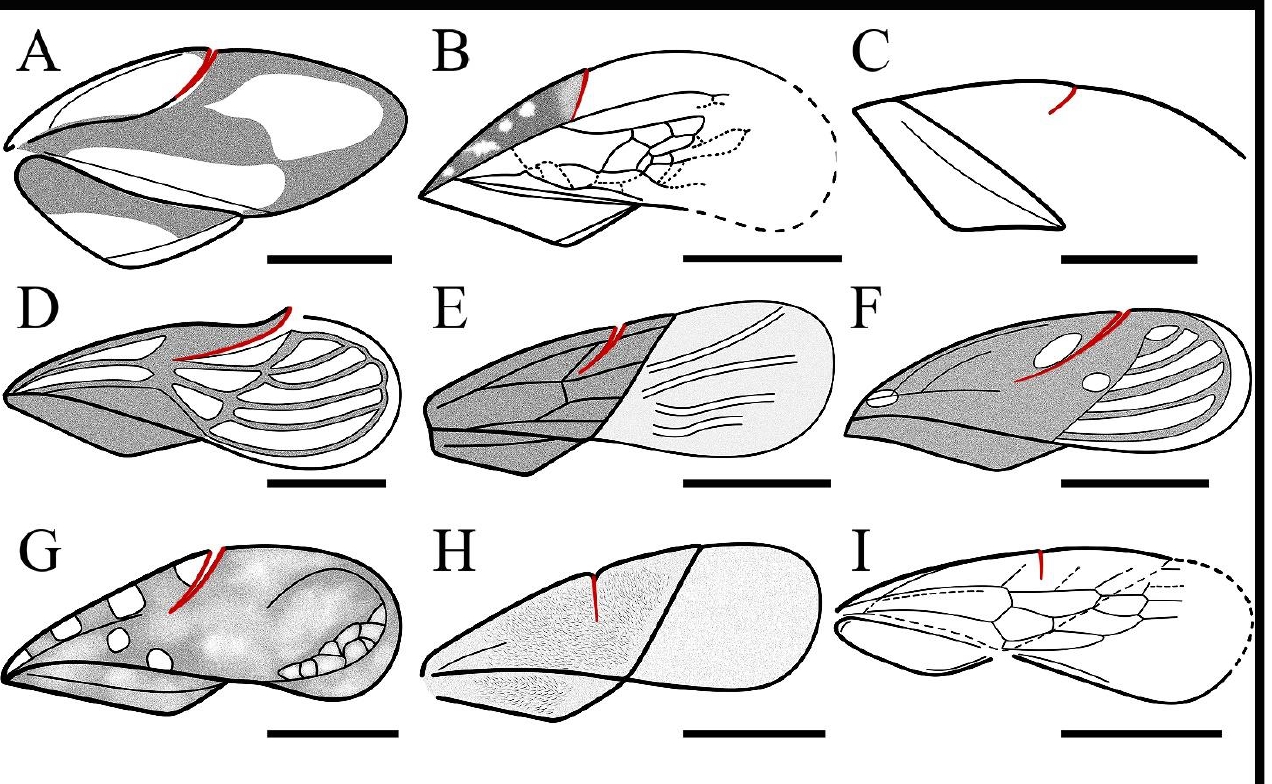
Figure 5. Redrawn from the forewings of other taxa of Heteroptera with changes. ( A ) Naucoroidea Arlecoris louisi Shcherbakov, 2010. ( B ) Belostomatidae Tarsabedus menkei Popov, Dolling and Whalley, 1994. ( C ) Corixidae Liassocorixa dorsetica Popov, Dolling and Whalley, 1994. ( D ) Archegocimicidae Mesolygaeus laiyangensis Ping, 1928 (Zhang et al., 2014). ( E ) Pachymeridiidae Bellicoris mirabilis Yao, Cai and Ren, 2008. ( F ) Saldidae Brevrimatus pulchalifer Zhang, Yao and Ren, 2011. ( G ) Ochteroidae Angulochterus quatrimaculatus Yao, Zhang and Ren, 2011. ( H ) Vetanthocoridae Punctivetanthocoris pubens Tang, Yao and Ren, 2016. ( I ) Nabidae Juracipeda popovi Shcherbakov, 2007. Scale bars: ( A ) = 1 mm; ( B ) = 10 mm; ( C , E – H ) = 2 mm; ( D , I ) = 1.5 mm. Redline shows the costal fracture.